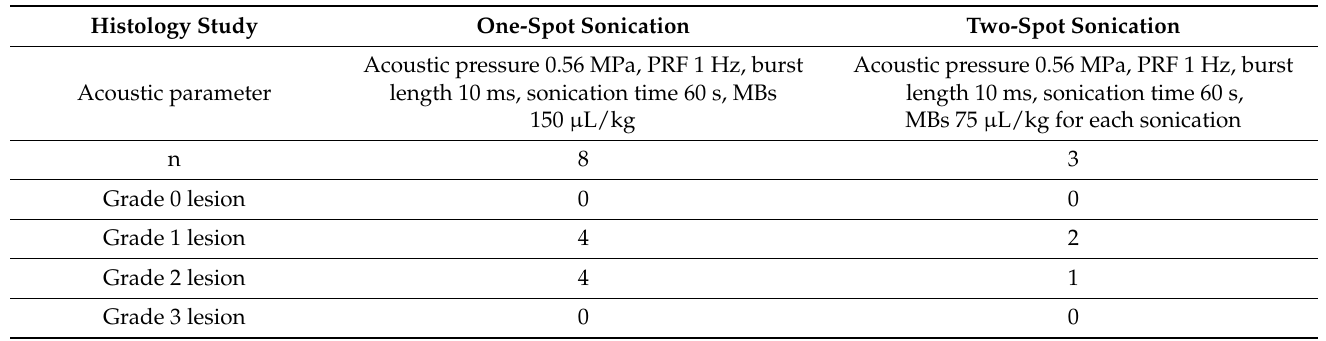
Table 2. Histology study for brain tissue damage